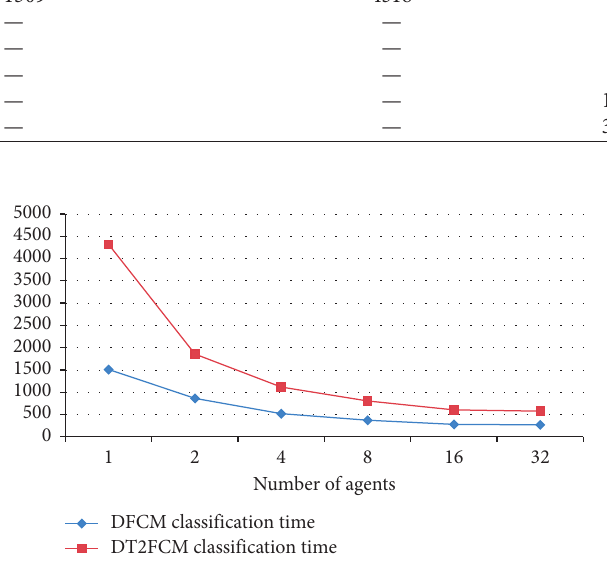
Figure 8: Classification time of the DT2FL and DFCM method based on the number of agents AVPE in the model.